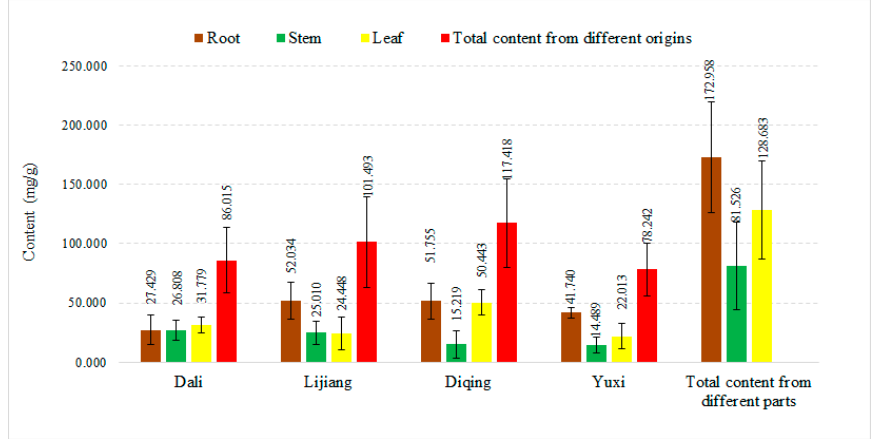
Figure 1. Contents of gentiopicroside in G. rigescens (mg/g) with different parts of plants from different geographical origins by HPLC.